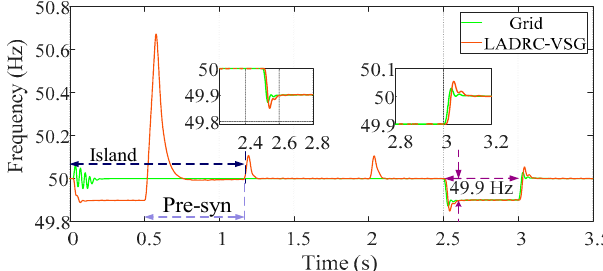
Figure 15. Frequencies of LADRC-VSG and grid measured by phase-locked loop (PLL). The di ff erence between the conventional VSG and PLL-VSG is that the PLL-VSG adopts the grid frequency as the frequency reference. Therefore, when the frequency does not fluctuate, the conventional VSG shares almost the same waveform with PLL-VSG (0–2.5 s). Figure 16 shows the output power